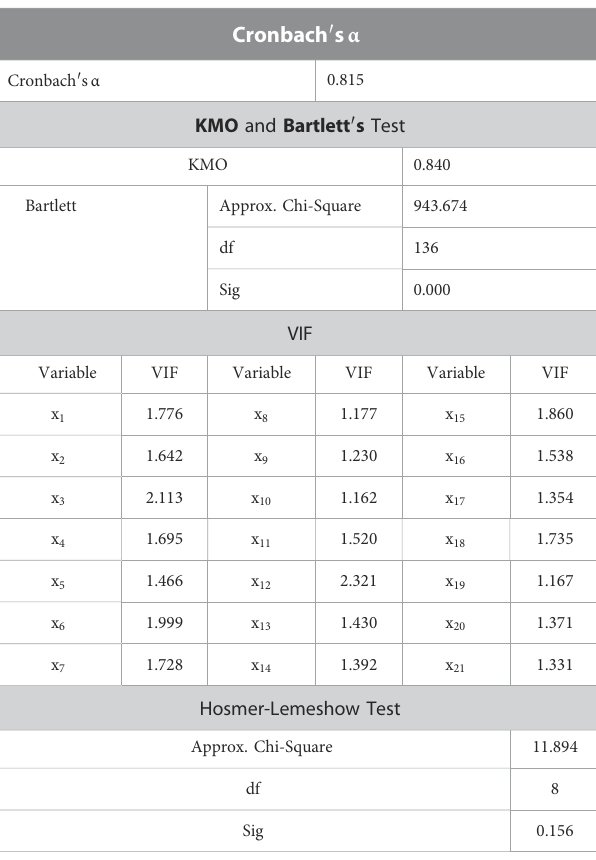
TABLE 4 The results of sample data